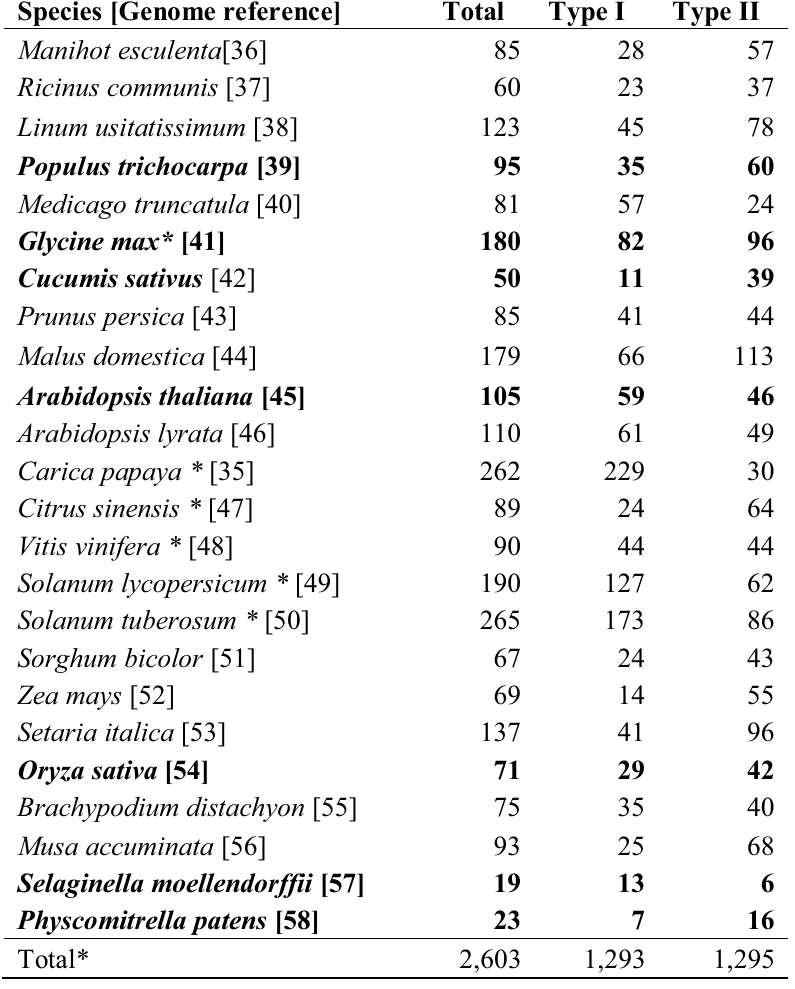
Table 2. Total number of MADS-box genes in 24 plant species and classification into Type I and Type II genes. The complete set of MADS-box genes was previously known for P. trichocarpa , G. max , C. sativus , A. thaliana , O. sativa , S. moellendorffii , and P. patens (indicated by bold writing) [6,8,9,21 (cid:177) 24]. * The remaining MADS-box genes could not be classified into Type I or Type